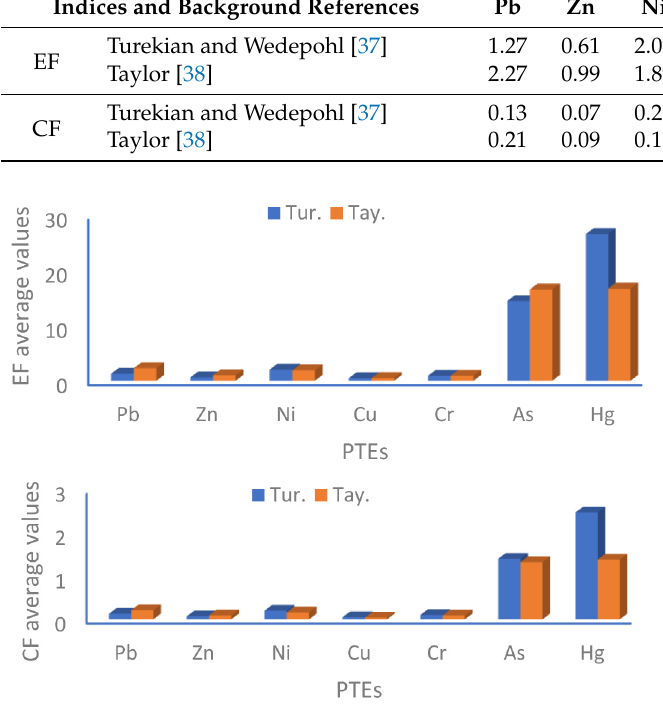
Figure 4. Distribution of EF and CF average values of PTEs based on background values